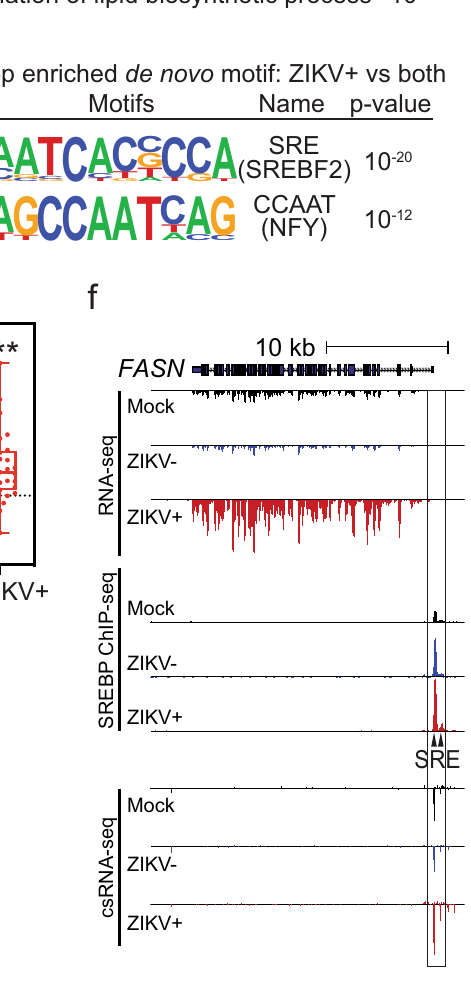
Fig. 4 | ZIKV infection of human moDCs increases SREBP recruitment and transcription of lipid-related genes. a – g ChIP-seq analysis was performed to detect SREBP TF binding to DNA in Mock, ZIKV − , or ZIKV+ moDCs from 3 donors infected for 24h with ZIKV PRVABC59 (MOI 1). a Number of upregulated (fold- change >1.5, false discovery rate <0.1) SREBP peaks. b Most enriched Metascape pathways among geneswith increased SREBPbinding inZIKV+ vs ZIKV − and Mock moDCs. c DenovomotifanalysisofupregulatedSREBPpeaksinZIKV+vsZIKV − and Mock moDCs. d , e Log 2 ratio of d SREBP or e csRNA-seq tags from − 500bp to +500bp at upregulated SREBPpeaksinZIKV+ orZIKV − vsMockmoDCs. Allpoints